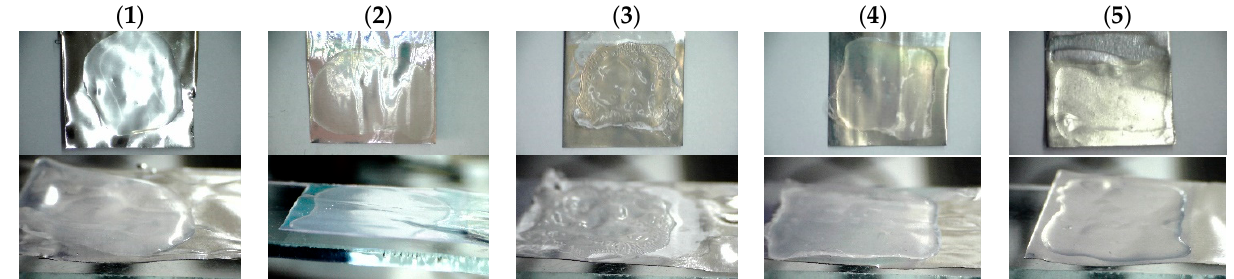
Figure 9. Pictures of polymer films on aluminum samples: ( 1 )—polymethylmethacrylate film on untreated aluminum; ( 2 )—polymethylmethacrylate film on anodized aluminum; ( 3 )—polytetrafluoroethylene copolymer film on anodized aluminum; ( 4 )—polyhexafluoropropylene film on anodized aluminum surface; ( 5 )—polyhexafluoropropylene film on modified and anodized aluminum surface.